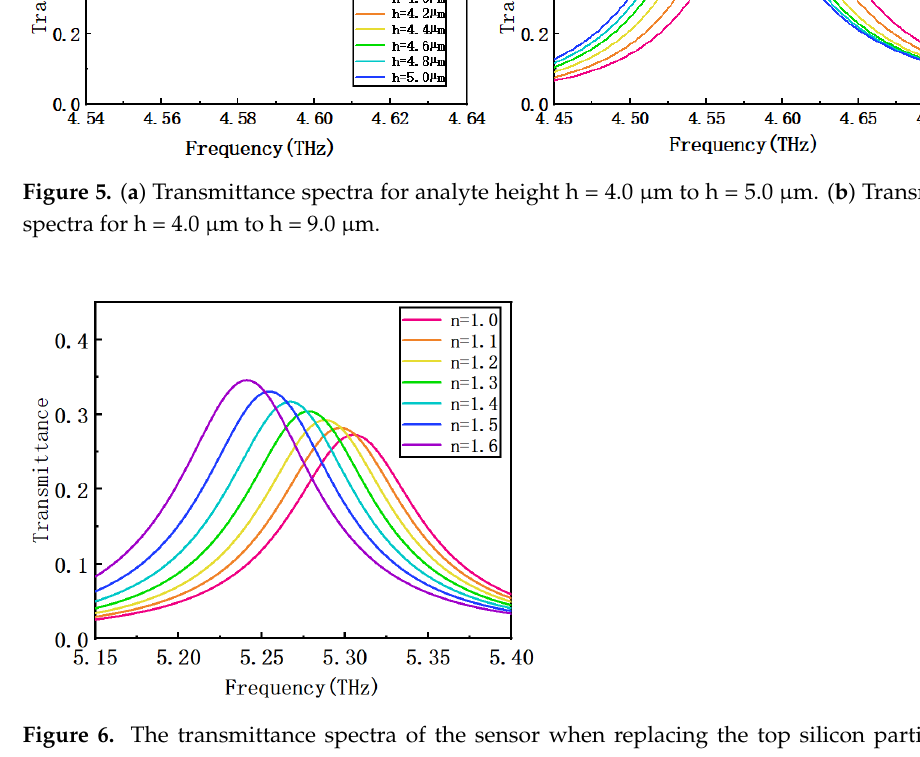
Figure 6. The transmittance spectra of the sensor when replacing the top silicon particle with the analyte.